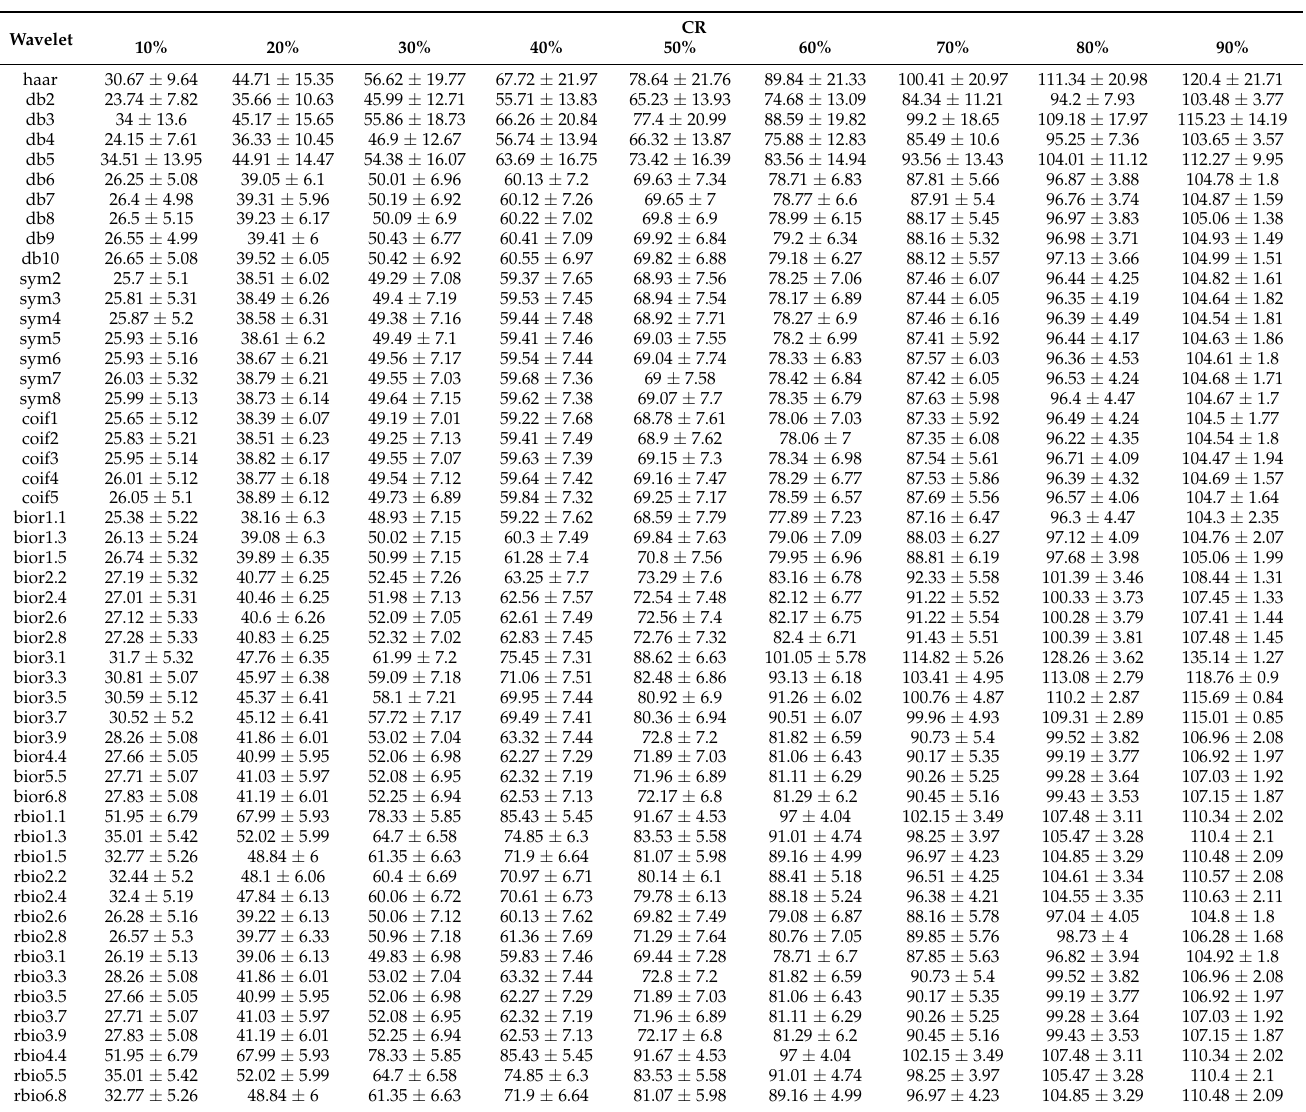
Table 1. PRD of reconstructed signals based on different wavelet bases. Values are means ±